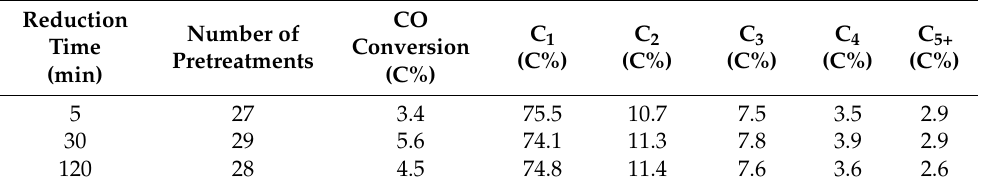
Table 2. Conversion and selectivities at the end of the experiment using one cobalt foil, last cycle (Series 2; Figure 1). The pretreatment involved calcination, reduction, and then CO hydrogenation. Time on stream for each FT test: 10 min.